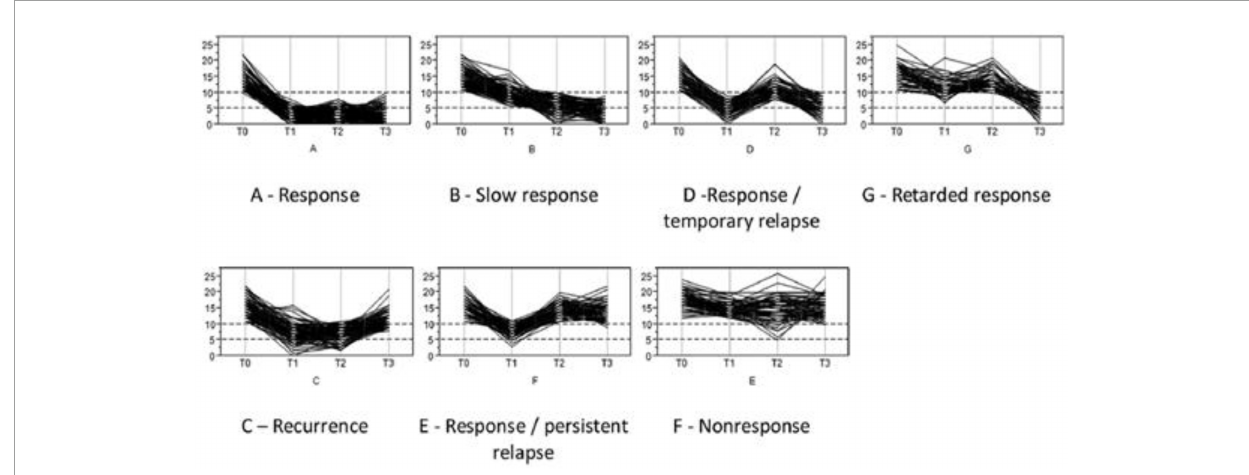
FIGURE1 The KML-cluster analysis yielded seven depression courses; patients of the INDDEP-study, eight study centers in Germany, 2011–2015 [reused from: (12). Reproduction approved by Elsevier publishing, license number: 5272891211810].